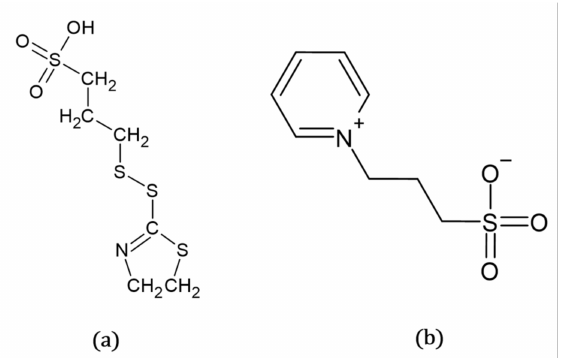
Figure 12. Molecular structure of single inhibitor material ( a ) SH110; ( b )